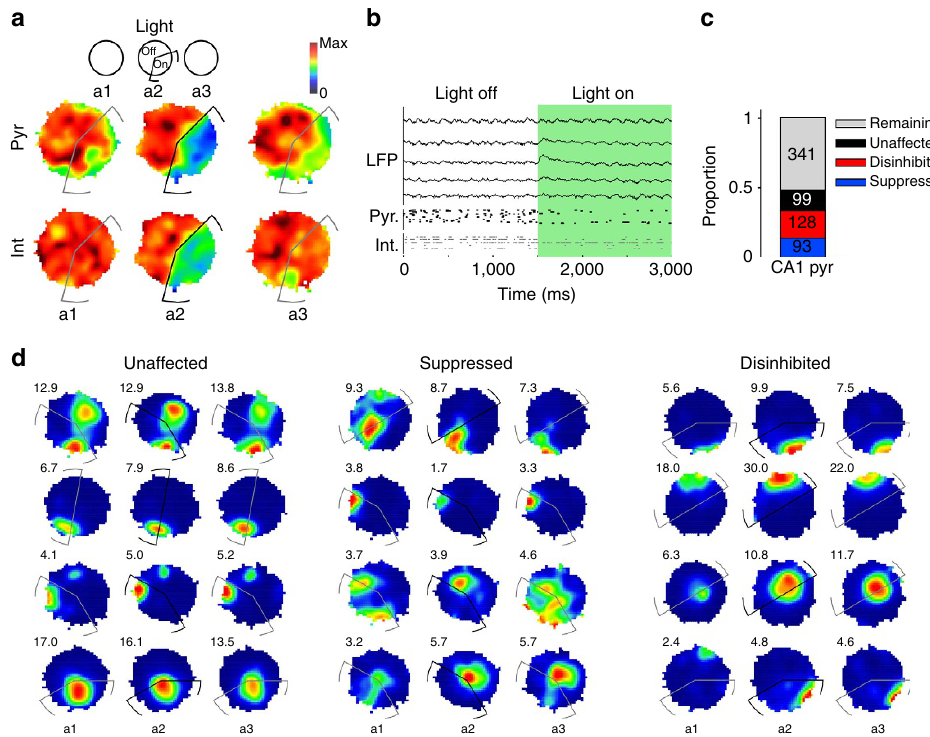
Figure 2 | Optogenetic manipulation of CA1 activity during exploration of familiar arena. ( a ) Top: schematic illustrating the three subsequent exploration sessions in a familiar environment (a1–a3). In session a2, the laser light was triggered when the animal entered a specific zone of the arena (‘light zone’, indicated by black line in a2). Each exploration session lasted 25min. Sessions were separated by 25min sleep/rest sessions in a sleep box. Bottom: cumulated pyramidal cell and interneuron firing maps for a representative recording day in which light application suppressed the rate of the majority of cells in the light zone in a2. Maps were normalized to the maximum rate on the map, as indicated on the map scale. ( b ) Wide-band signal and unit activity while the animal enters the light zone. Green area marks light application. ( c ) Proportions and cell numbers for different cell categories. Rate changes in the light zone during session a2 were used to classify cells. Only neurons passing place-cell criteria in sessions a1 and/or a3 were included in the analysis. Total CA1 pyramidal cells in familiar paradigm, n ¼ 661 in 9 recording days in 4 animals. ( d ) Place fields of example pyramidal cells. Numbers on the top left of the maps represent the peak firing rates on the map (Hz). Peak rate on the maps were plotted in red, whereas parts of the environment with low rate were plotted in